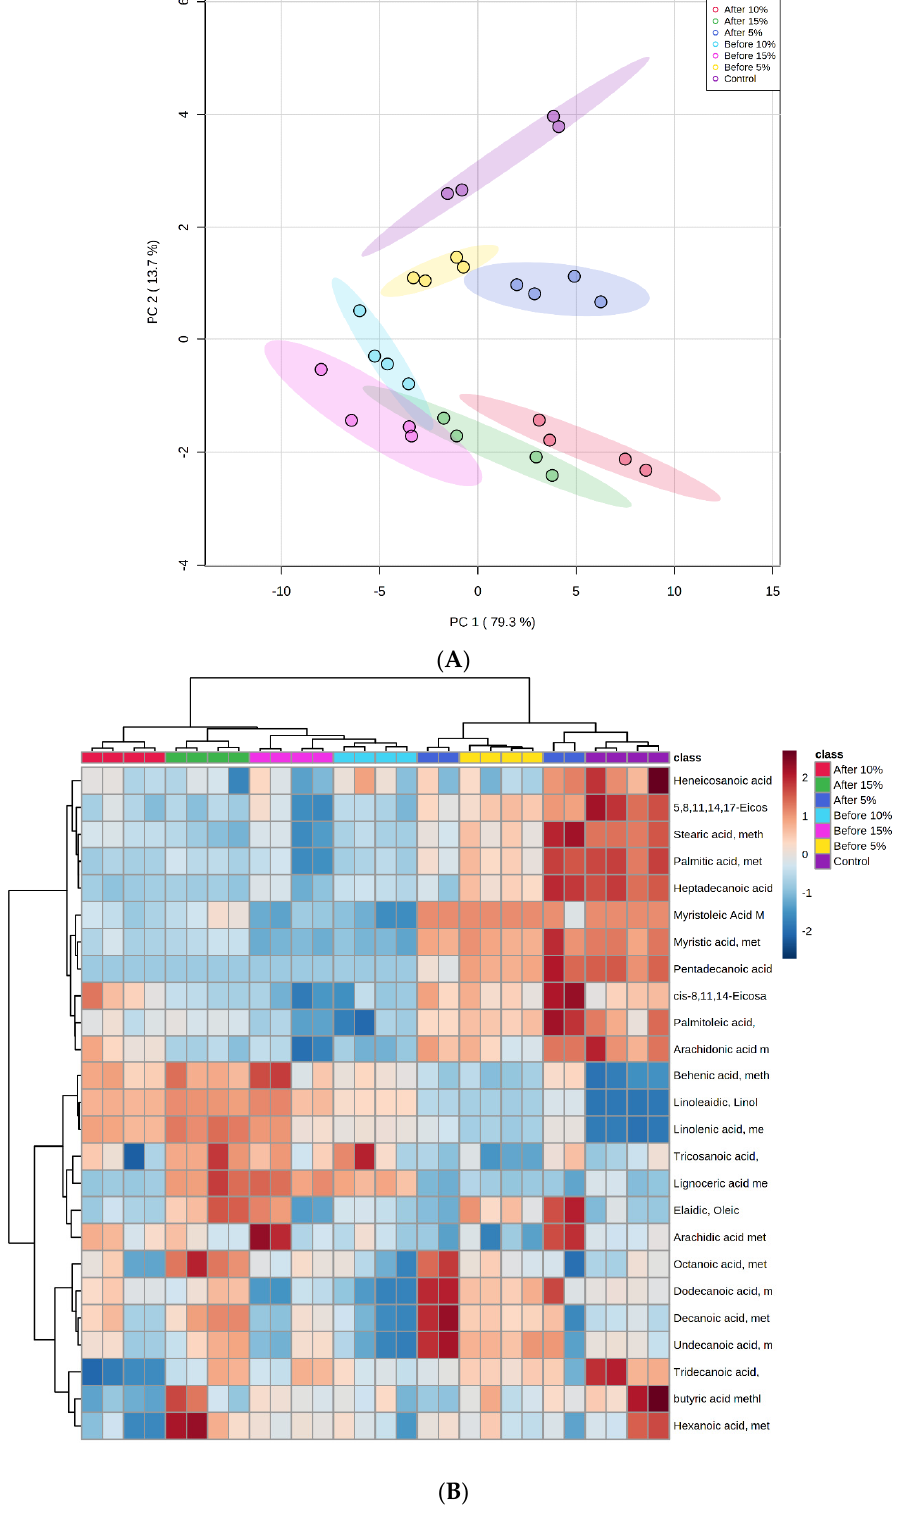
Figure 2. Score plot ( A ) and heatmap ( B ) diagrams from the principal component analysis of fatty acid contents for control yoghurt and tamarillo yoghurts produced from two fermentation processes. The vertical bar (2 to − 2) from deep red to deep blue shows high to low levels of each fatty acid in different groups of yoghurt samples.